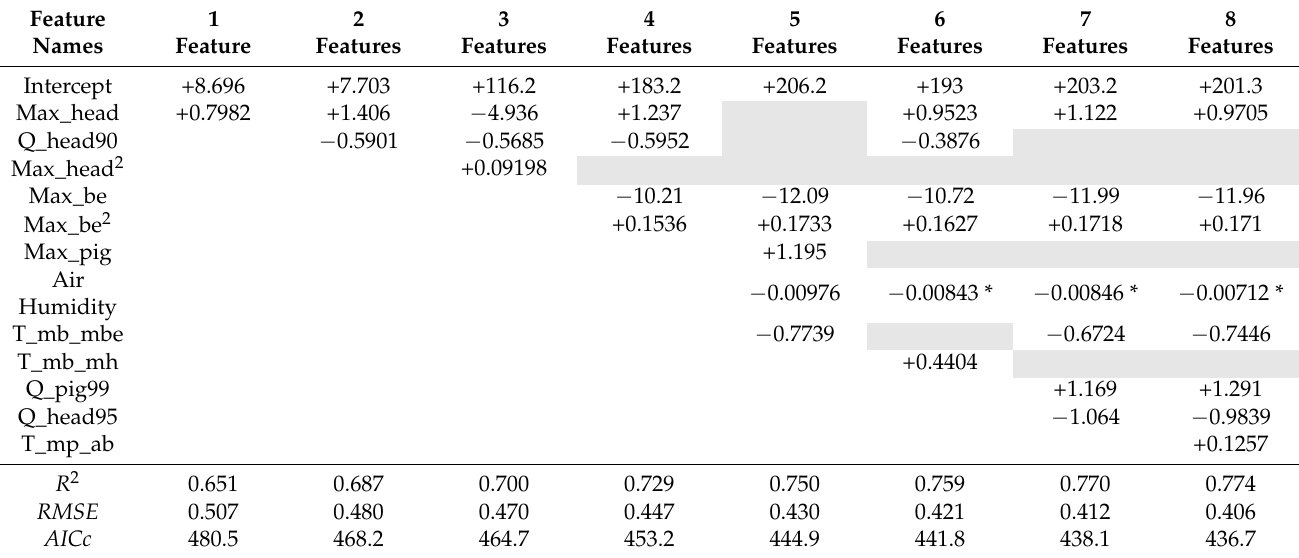
Table 4. The best multiple linear regression models of all features (62) on rectal temperature with varying numbers of features (1–8) plus intercept. R 2 is the coefficient of determination, RMSE is the root mean square error, and AICc is a variation of the Akaike information criterion for small sample sizes.